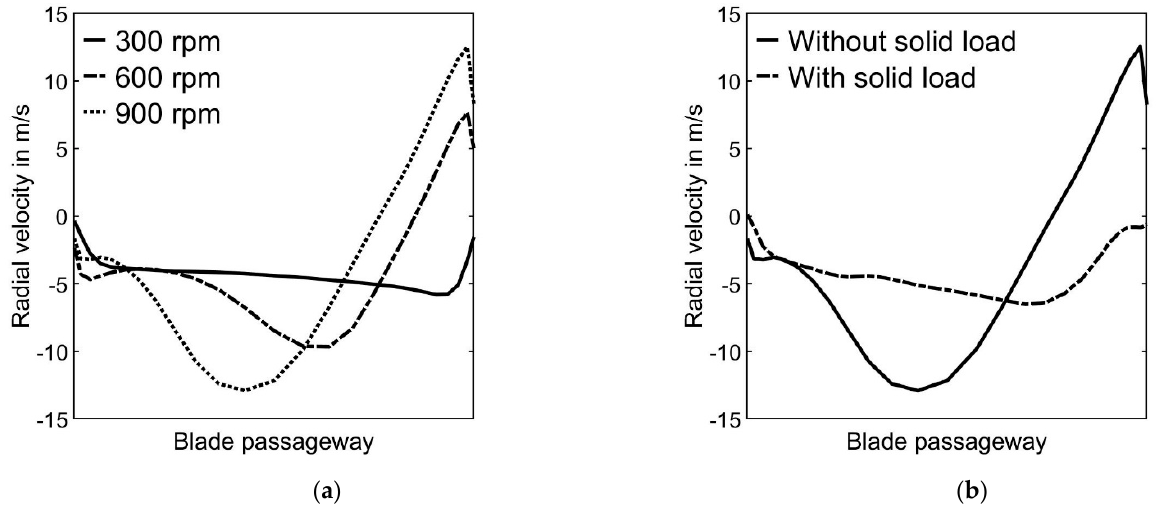
Figure 6. ( a ) Radial velocity between classifier blades for three different classifier speeds with no solid load; ( b ) radial velocity between classifier blades with and without solid load at 900 rpm.